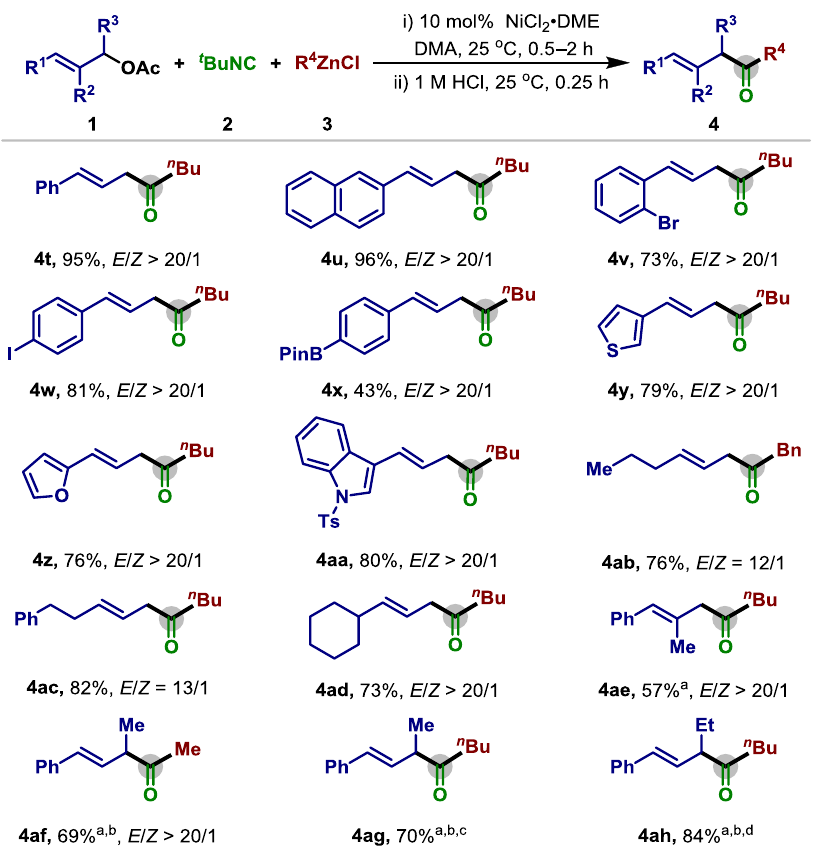
Fig. 3 Scope of allyl acetate for nickel-catalyzed allylic carbonylative Negishi reaction. Reaction conditions: 1 (0.2 mmol), 2 (0.3 mmol), 3 (0.3 mmol), NiCl 2 ·DME (0.02 mmol), DMA (2 mL), 25 °C, 0.5 h, and then 1 M HCl. a 50 °C; b Ni(cod) 2 (0.02 mmol); c the ratio of regioisomer is 6:1; d the ratio of regioisomer is